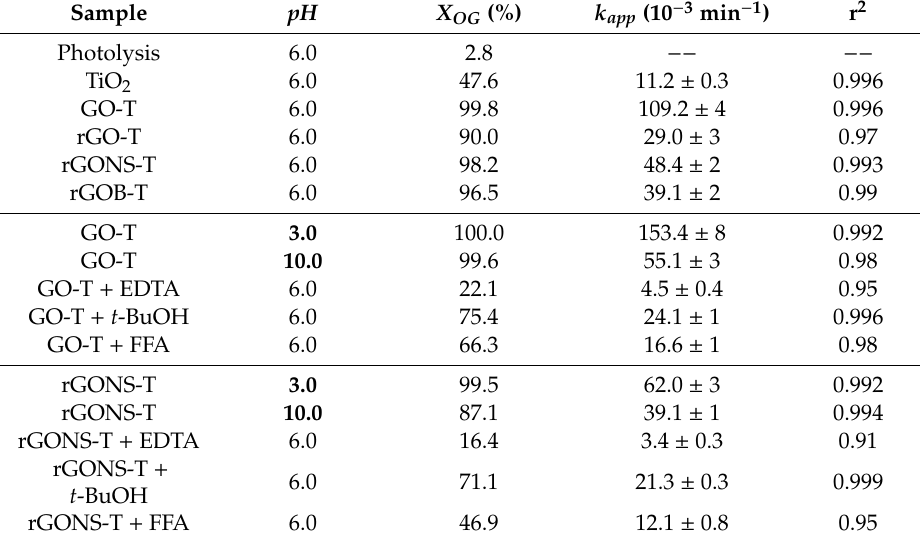
Table 2. OG conversion after 60 min ( X OG ), pseudo-first order kinetic rate constant ( k app ), and regression coe ffi cient ( r 2 ) of